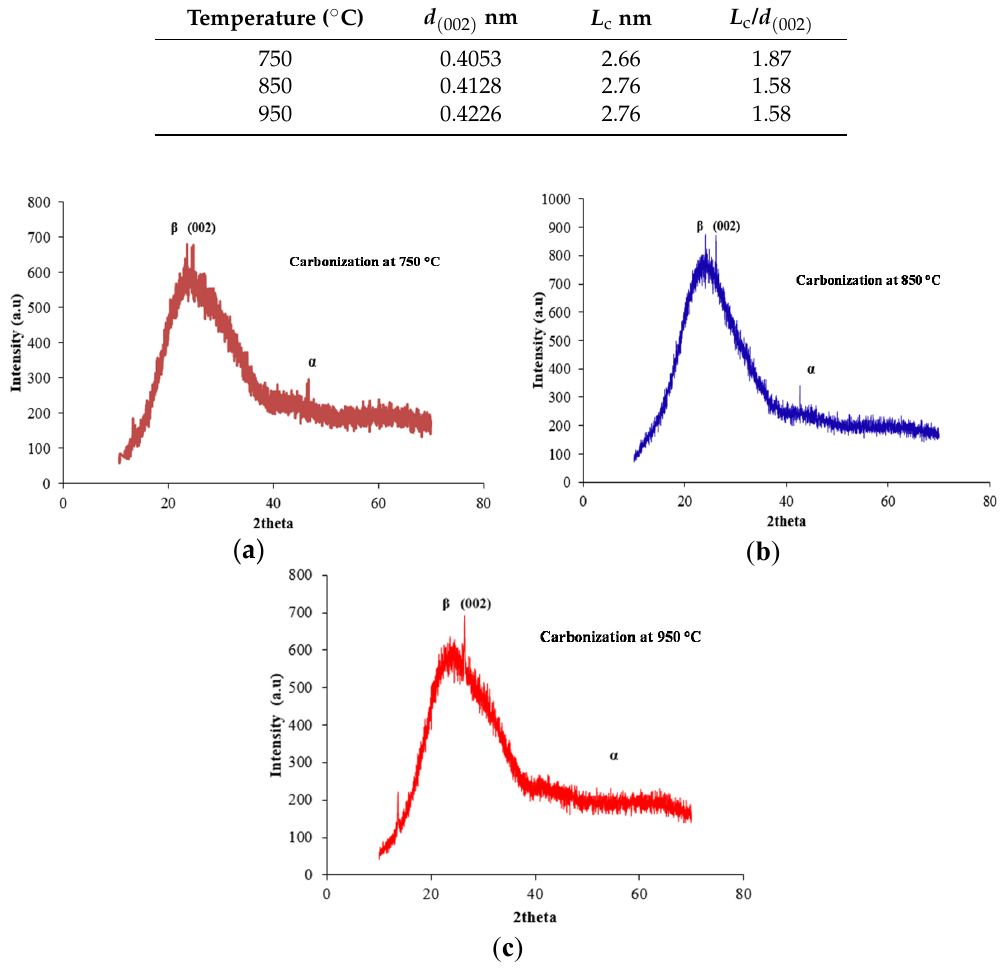
Figure 1. ( a ) X ‐ ray diffraction (XRD) pattern of PAN pre ‐ carbonized fibers at 750 °C; ( b ) XRD pattern of PAN pre ‐ carbonized fibers at 850 °C; ( c ) XRD pattern of PAN pre ‐ carbonized fibers at 950 °C.